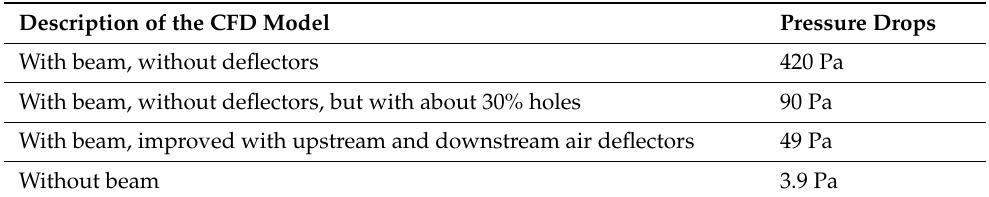
Table 5. Total pressure drops for a beam size of 388 mm and an air inlet velocity of 7.9 m/s (the height greater than half of the ventilation duct